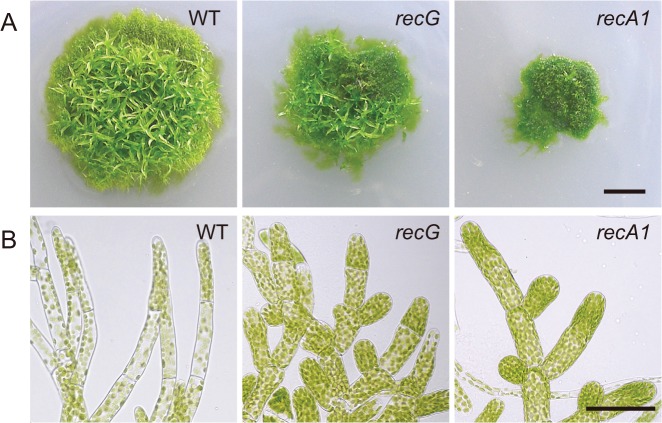
Cell growth and morphology of RECG KO plants.
A. Colonies of wild type (WT), RECG KO (recG-2) or RECA1 KO plants cultivated on agar medium for four weeks. B. Protonemal cells. Bars = 5 mm in (A) and 50 μm in (B). Atrophic protonemal cells (S3 Fig.) are shown as RECG KO cells.